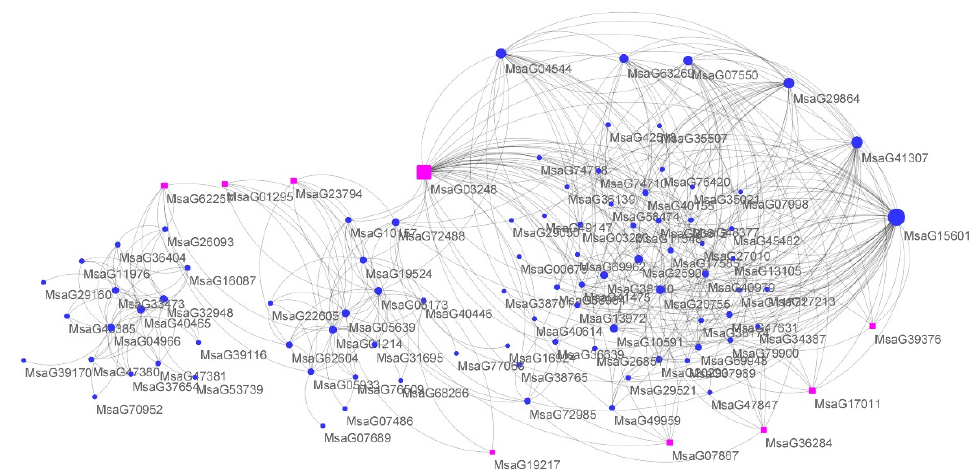
Figure 6. Gene networks in response to cold stress from the model MEbrown4. Note: The modules of genes from model MEbrown4 were exported, and the results and GRN were reconstructed based on the WGCNA results, which were analyzed and displayed using Cytoscape. Gene node size is proportional to the number of interactions (degree), and rectangle shapes correspond to genes involved in ribosome biogenesis process.